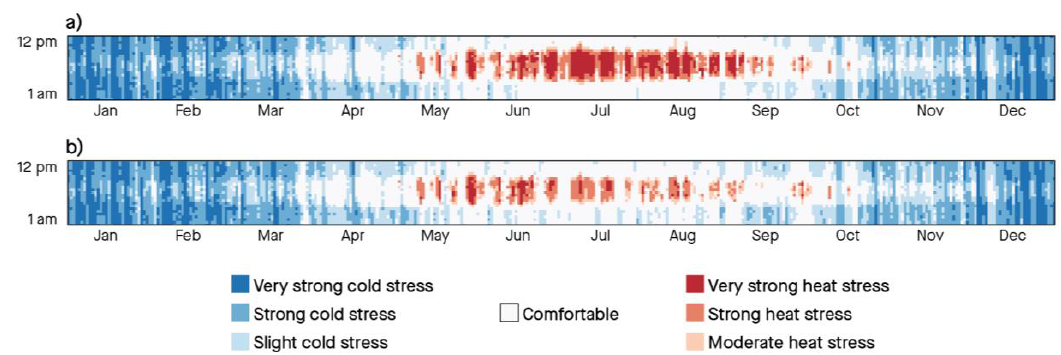
Figure 6. Annual UTCI heat maps for Baltimore. The vertical dimension indicates the time of day and the horizontal dimension indicates time of year. ( a ) is derived from the baseline weather station data and ( b ) assumes a 17 ◦ C reduction in mean radiant temperature (MRT) and 0.5 m / s increase in wind speed during the summer only. With these interventions, the annual comfortable duration is increased by 5%.